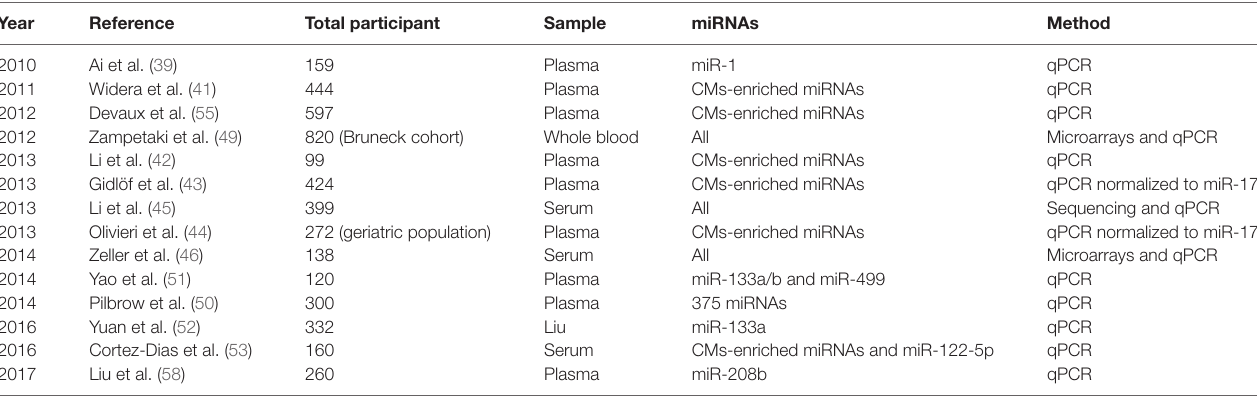
TABLe 1 | List of large cohort studies on cardiomyocytes (CMs)-enriched microRNAs (miRNAs) as AMI